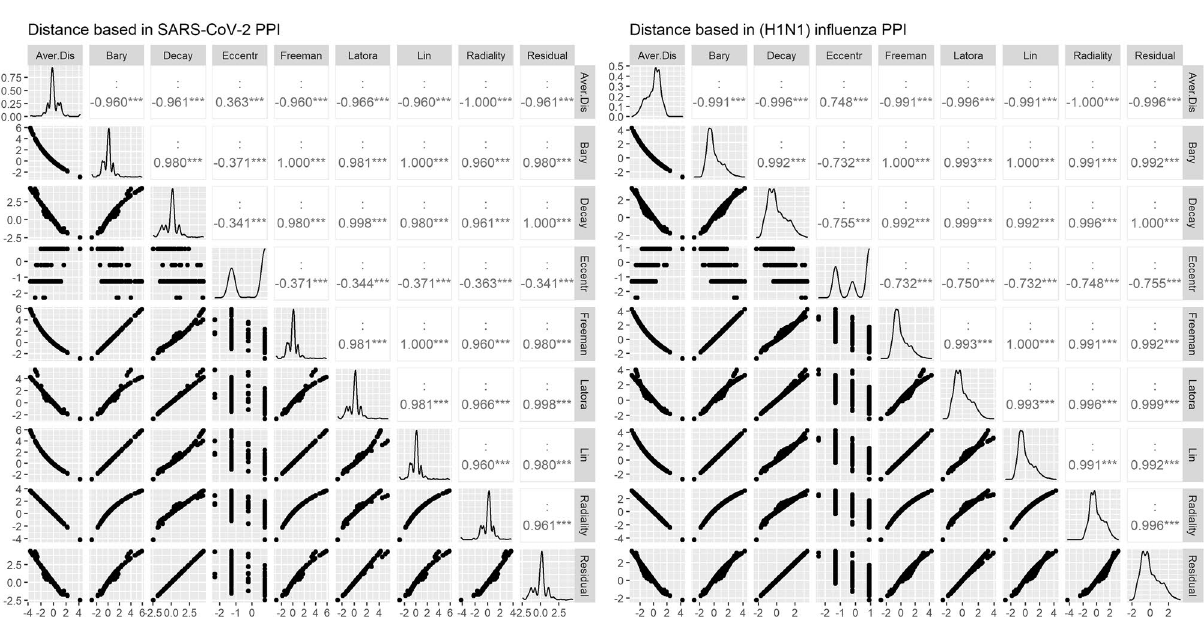
Figure 2. r Pearson correlation coefficients between centralities in the group of Distance based and pairwise scatter plots of centrality